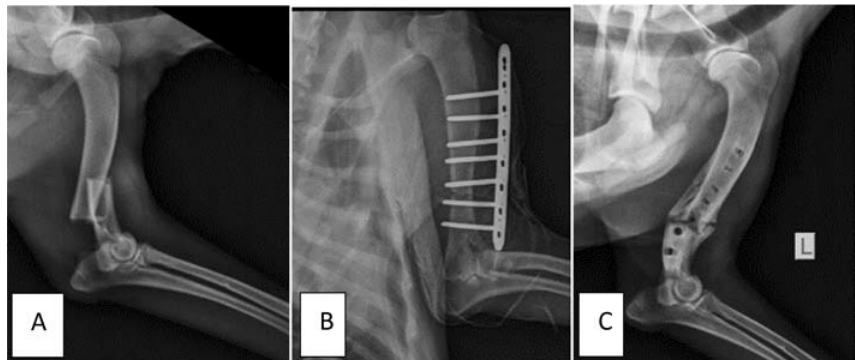
Fig. 2. (A) Preoperative radiograph (B) Immediate postoperative radiograph (C) Radiograph after implant